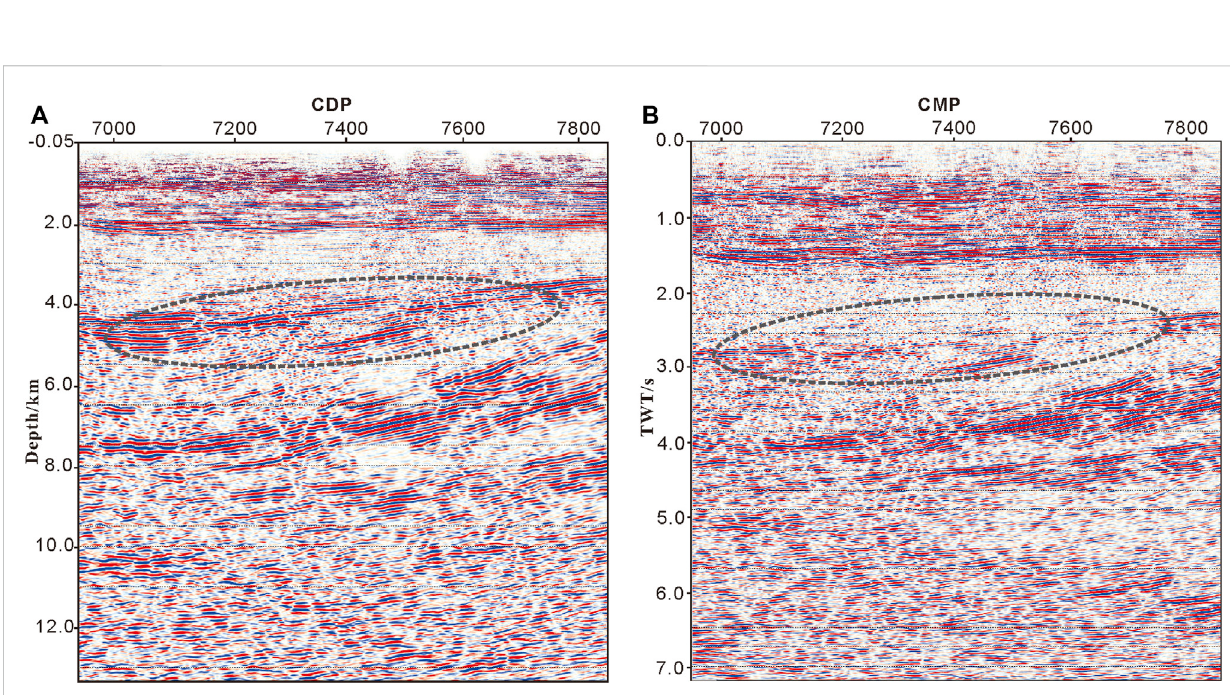
Frontiers in Earth